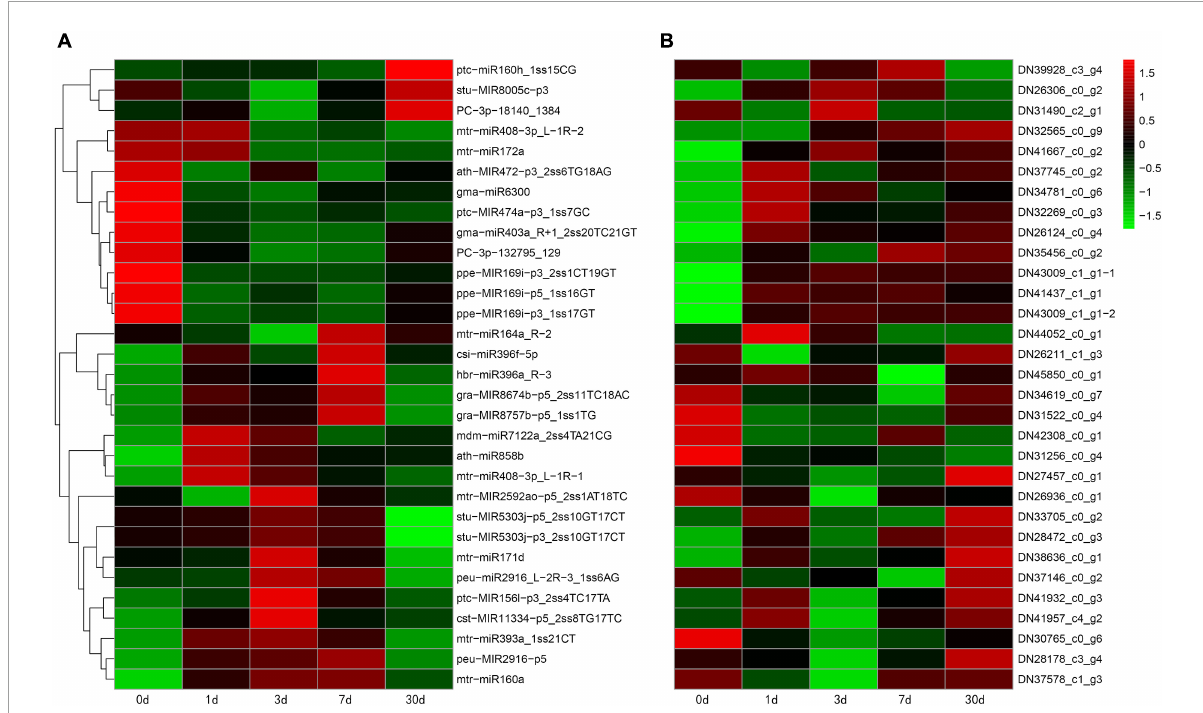
FIGURE5 Combined view of expression levels between differentially expressed miRNAs (A) and their target genes (B) in C. oleifera at five different Pi treatment durations. The original expression values of miRNAs and their target genes were normalized by Z-score normalization.